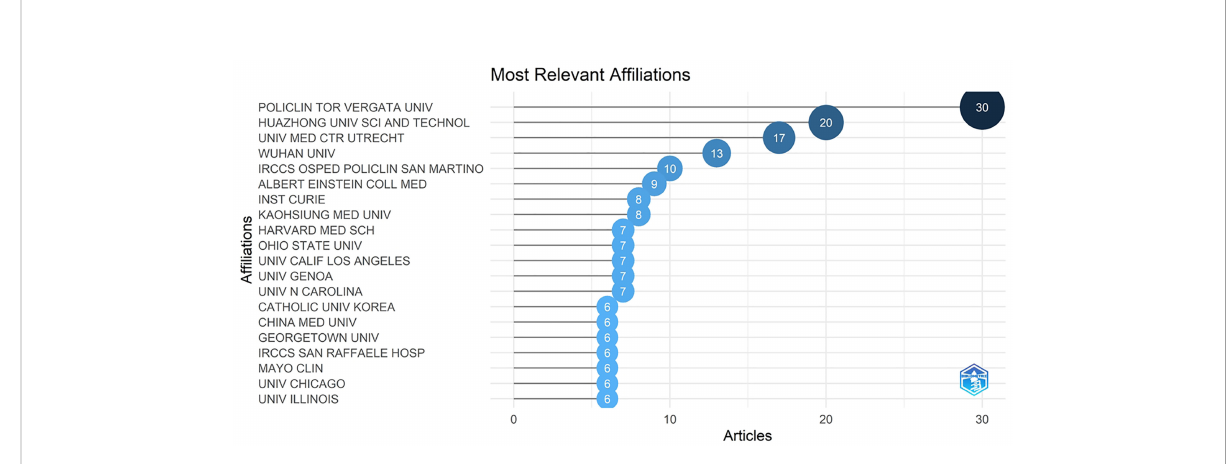
FIGURE 3 The most relevant af fi liations linked to articles of BCMP (top 20).